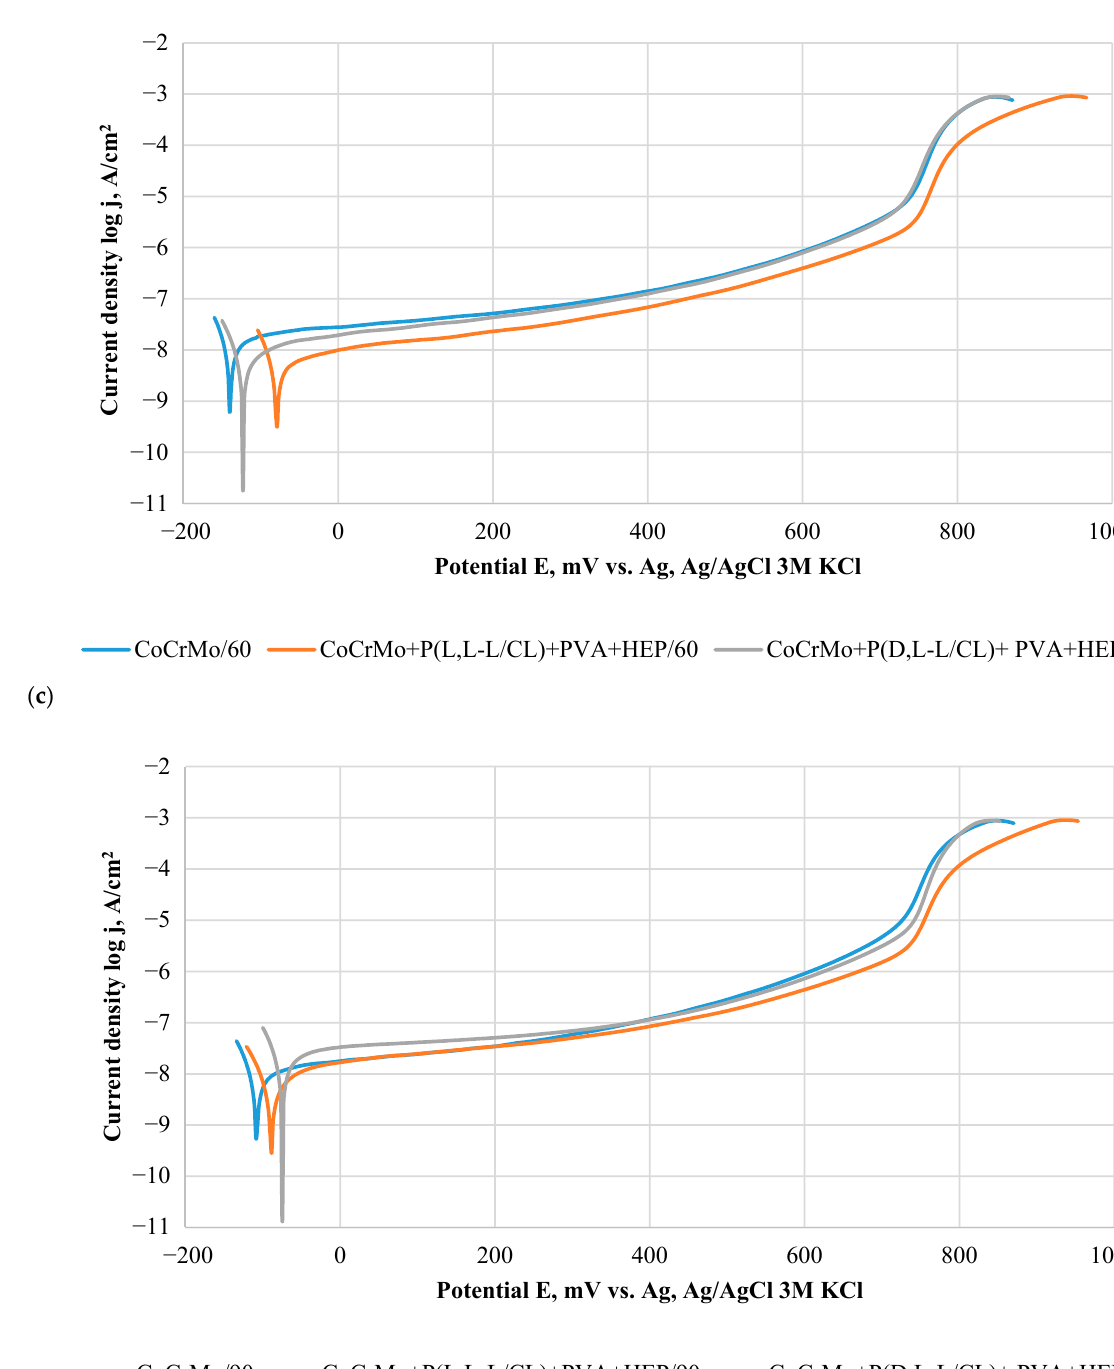
Figure 5. Exemplary polarization curves for the tested variants of CoCrMo alloy surface modification. ( a ) Initial state; ( b ) after 30 days; ( c ) after 60 days; ( d ) after 90 days, of exposure to artificial urine. Table 3. Results of potentiodynamic tests of resistance to pitting corrosion of CoCrMo alloy modified with biodegradable heparin-releasing coatings exposed to artificial urine for up to 90 days.